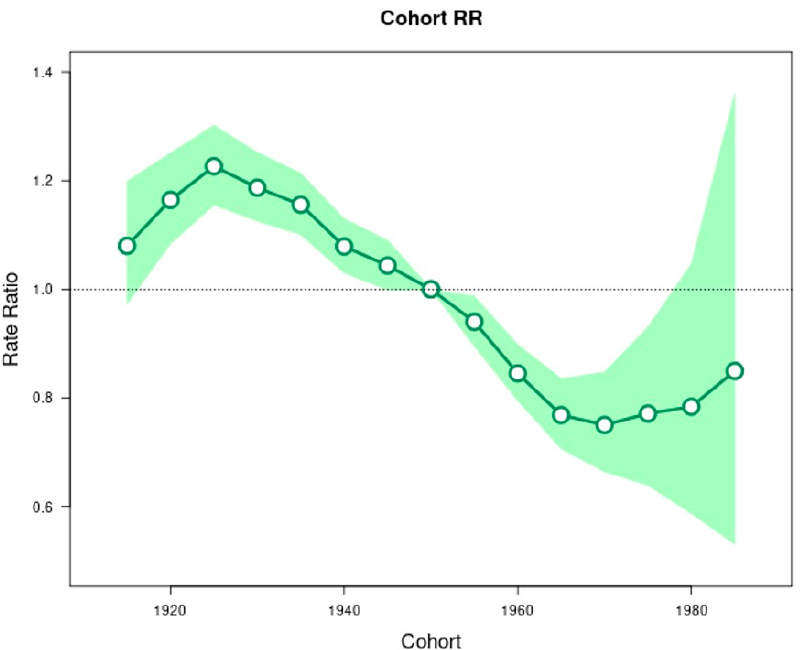
Figure 4. Incidence rate ratios by birth cohort (reference = cohort 1950) for esophageal cancer incidence in SEER 12 database. Shaded bands indicate the 95% confidence interval.